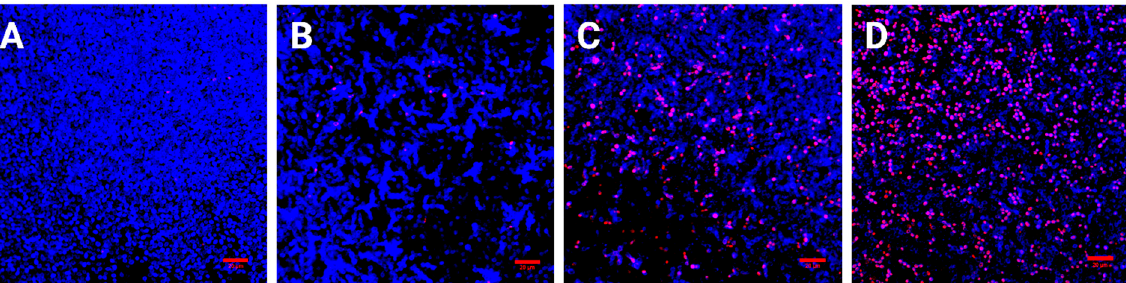
MB; ( A ) control 24 h biofilm; ( B ) MB Dark group; and ( C ) MB groups irradiated for 120 s ( D ) and 300 s. Bars represent 20 µ m. The cell wall was stained with CW (1 µ g/mL) and dead cells were stained with PI (0.1 µ